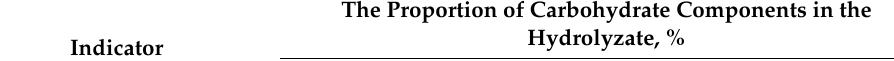
Table 3. Results of the carbohydrate composition analysis of collagen-containing waste hydrolysis